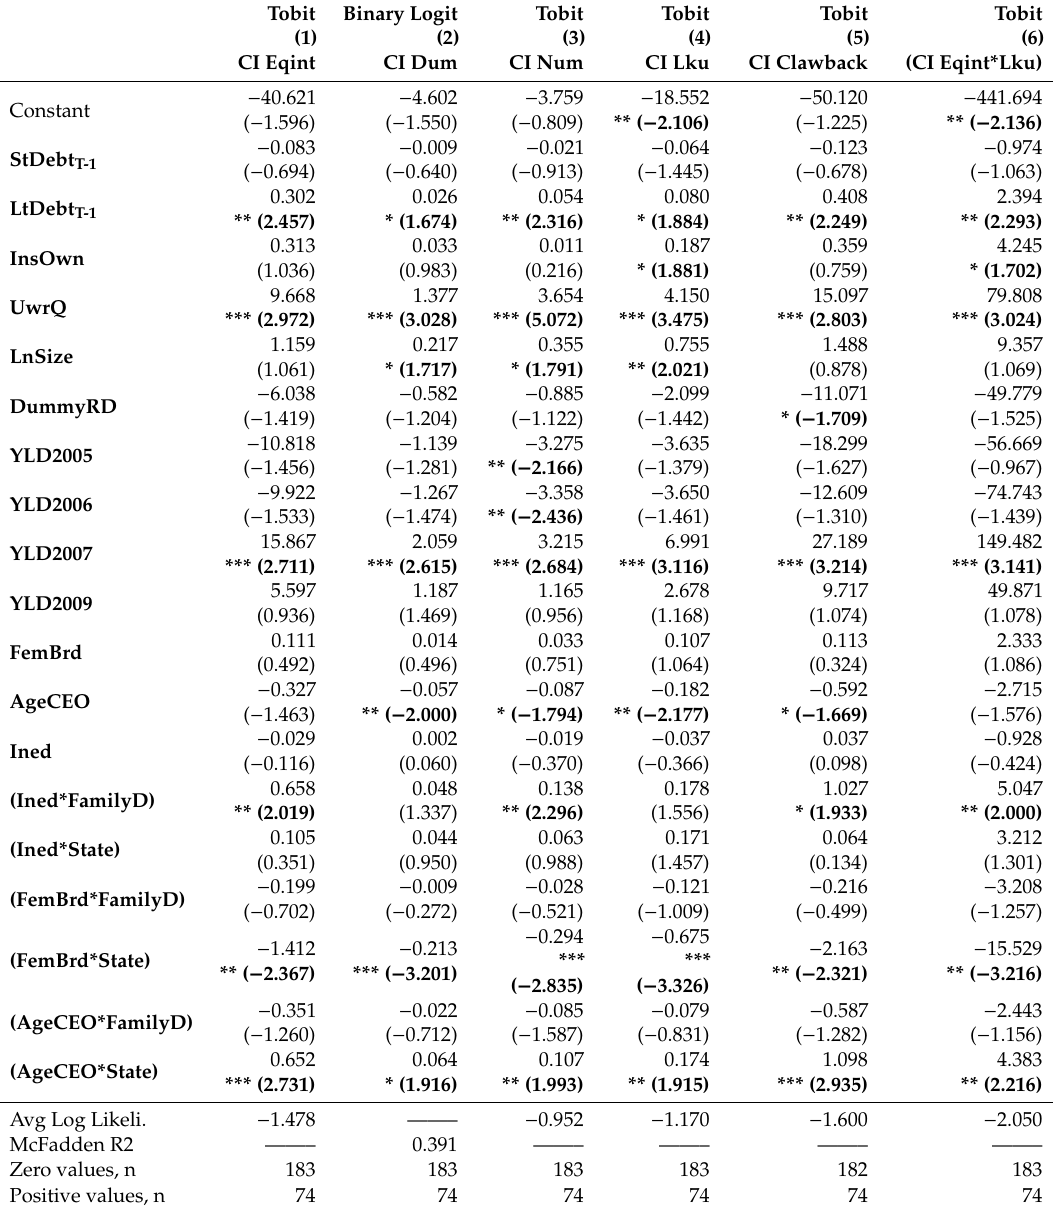
Table 4. Determinants of cornerstone participation (including interaction